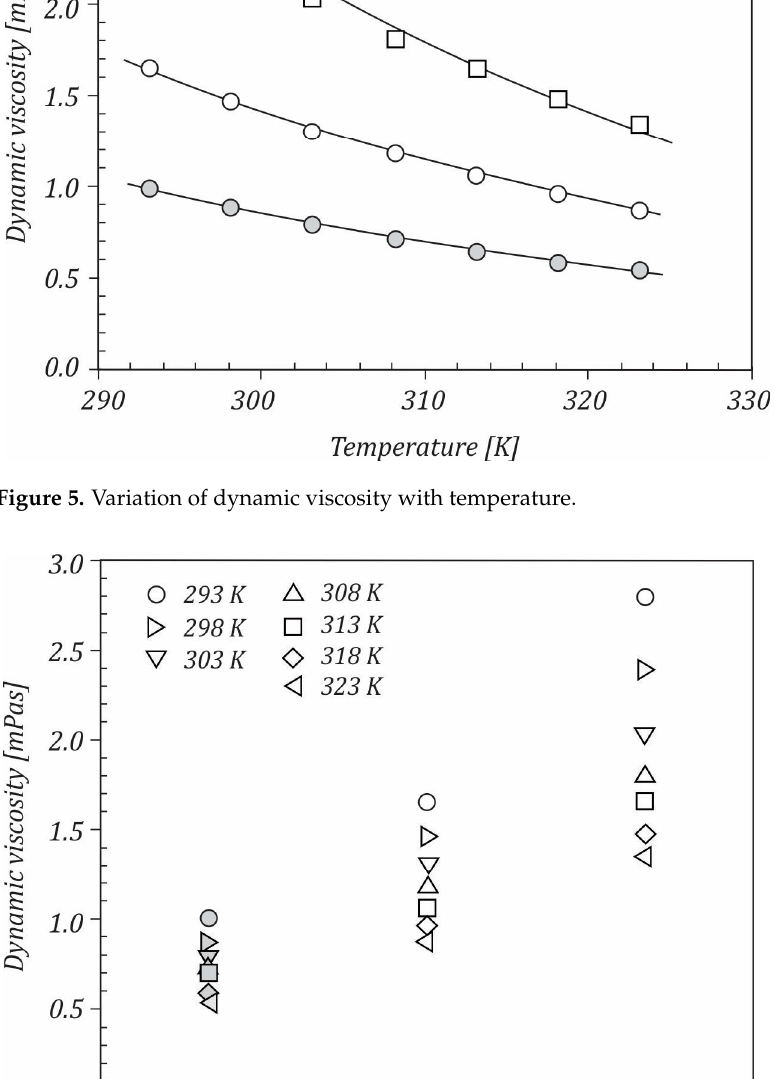
Figure 7. Variation of relative dynamic viscosity with temperature. A comparison of the dynamic viscosity values achieved for the 0.2 GO- 0.8 Si hybrid nanofluid with the results for mono nanofluids is depicted in Figure 8. It is seen that